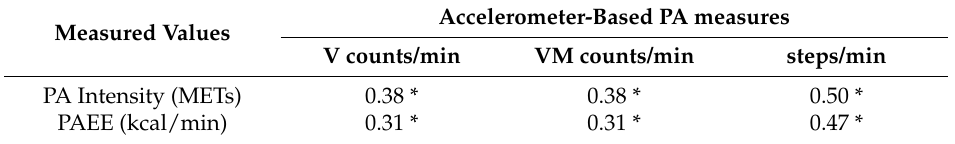
Table 4. Correlation Coefficients ( r ) among Measured PAEE, PA Intensity, Counts and Cadence. Accelerometer-Based PA Measured Values